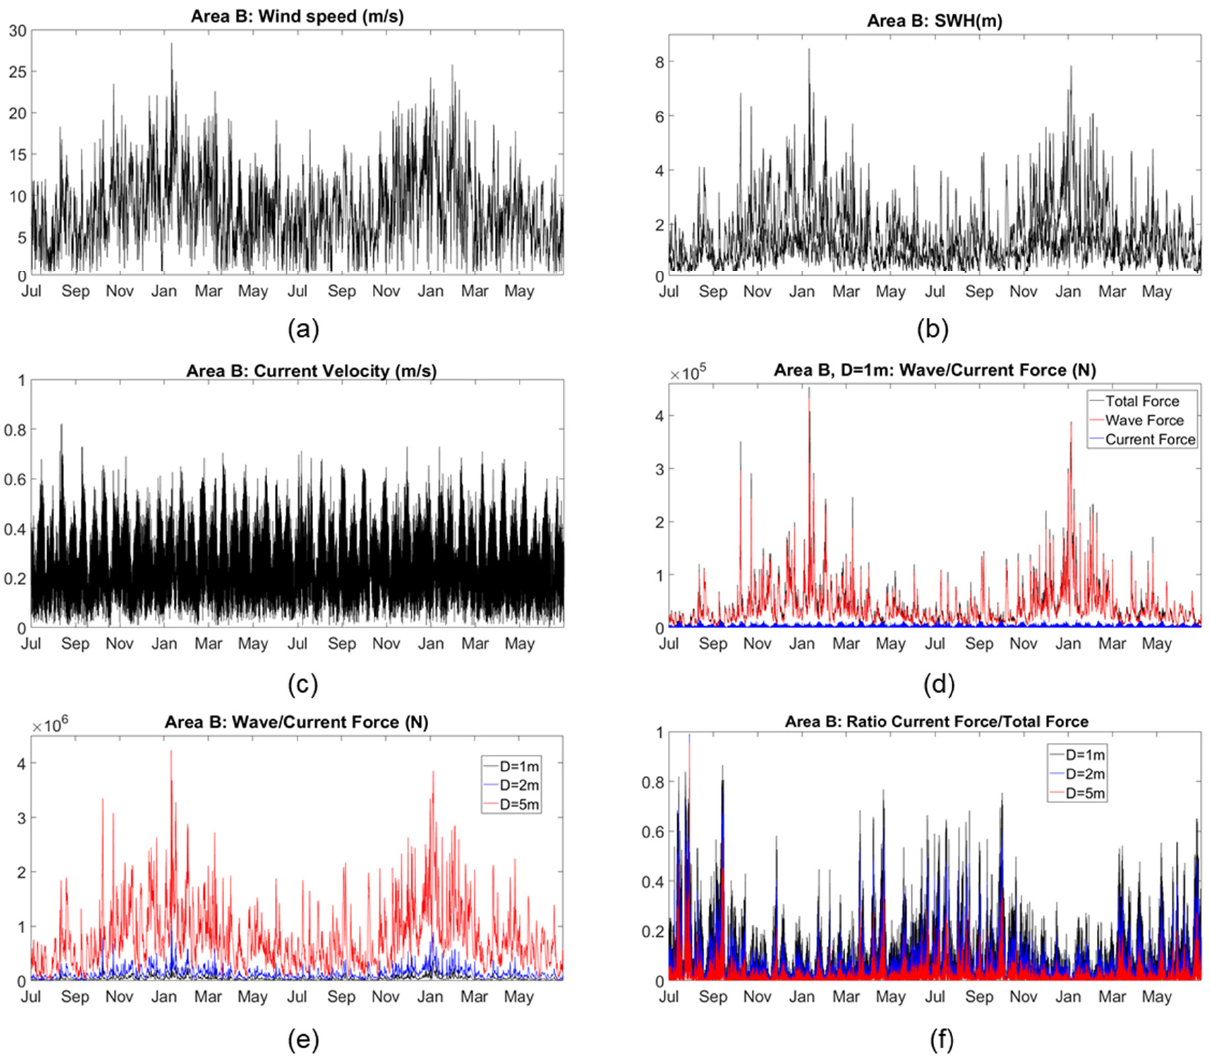
Figure 9. Area B hourly time series (7/2014–6/2016) of area-averaged wind speed (m/s) ( a ) Significant Wave Height (m) ( b ), Current velocity (m/s) ( c ), total wave/current force (N) (black), wave force (N) (red) and current force (N) (blue) ( d ) on a pile of diameter 𝐷 = 1 m. Timeseries of total force ( e ) and ratio of current to total Force ( f ) for 𝐷 = 1 m, 𝐷 = 2 m, and 𝐷 = 5 m.